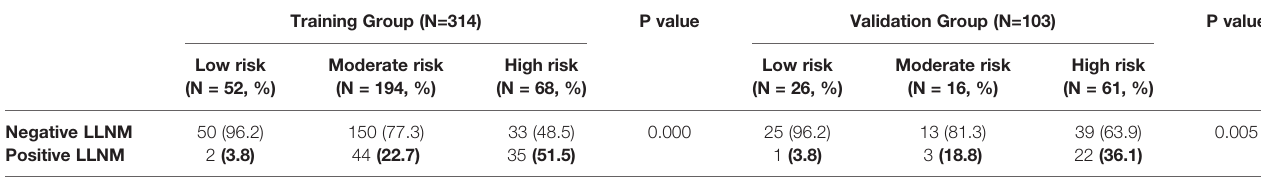
TABLE 5 | Risk strati fi cation of PTC patients located in upper